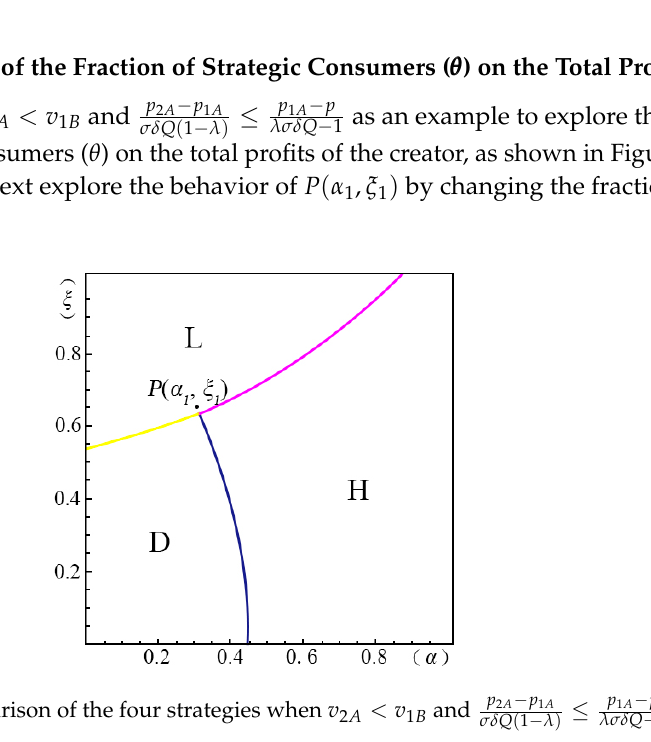
Figure 8. Comparison of the four strategies when v 2 A < v 1 B and p 2 A − p 1 A